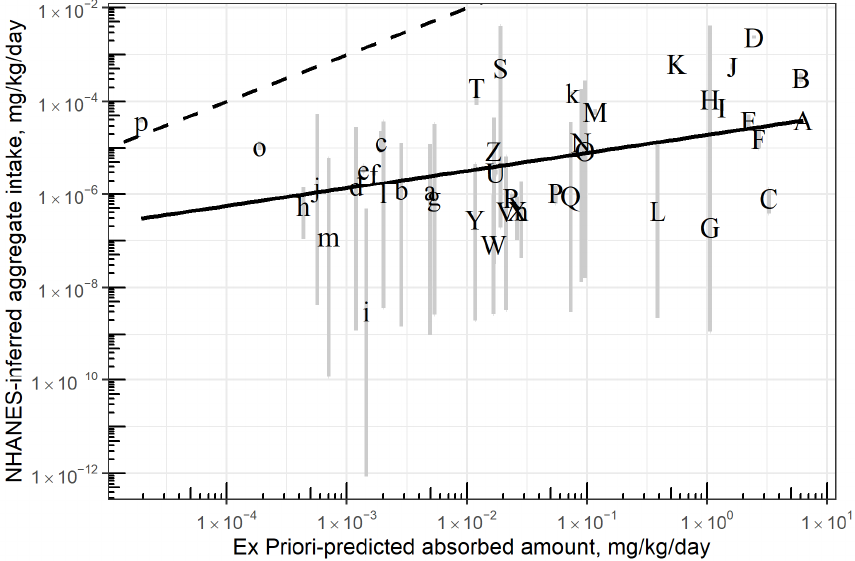
Figure 4. NHANES-inferred aggregate exposure vs. Ex Priori -predicted absorbed amount, each in mg/kg/day, on log10-log10 scale, for 42 chemicals. Each letter represents one chemical; lower-case letters represent different chemicals from their corresponding upper-case letters (e.g., “A” and “a” represent two different, unrelated chemicals). Gray vertical line segments represent range of 95% credible interval bounds on NHANES-inferred median aggregate exposures. Dashed diagonal line represents the identity line, y = x. Solid diagonal line represents the best-fit linear regression model, i.e., log10(y) = − 4.7 + 0.38 log10(x), where y = NHANES-inferred aggregate exposure and x = Ex Priori -predicted absorbed amount converted to mg/kg/day. See text for details on linear regression. See Supplemental Material Table S7 to map letter codes to chemical names and CASRN.